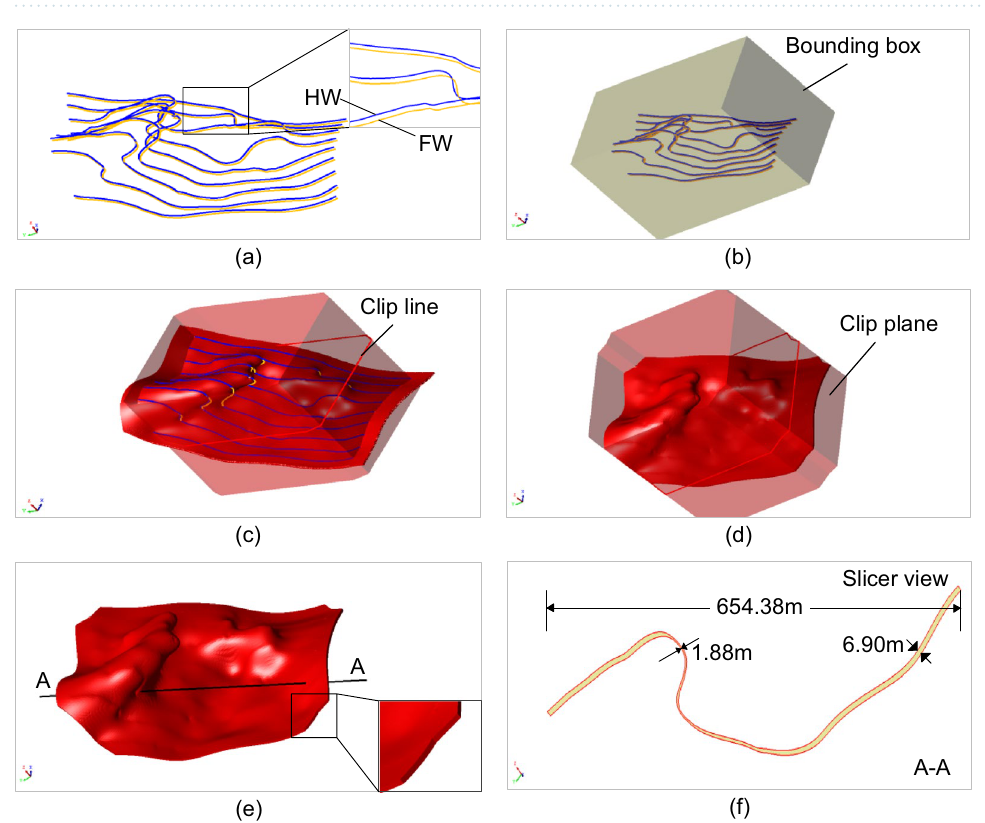
Figure 8. Implicit modeling of a narrow vein orebody model. ( a ) Contour polyline data; ( b ) rectangle bounding box; ( c ) initial model; ( d ) clipped model; ( e ) final model; ( f ) slicer